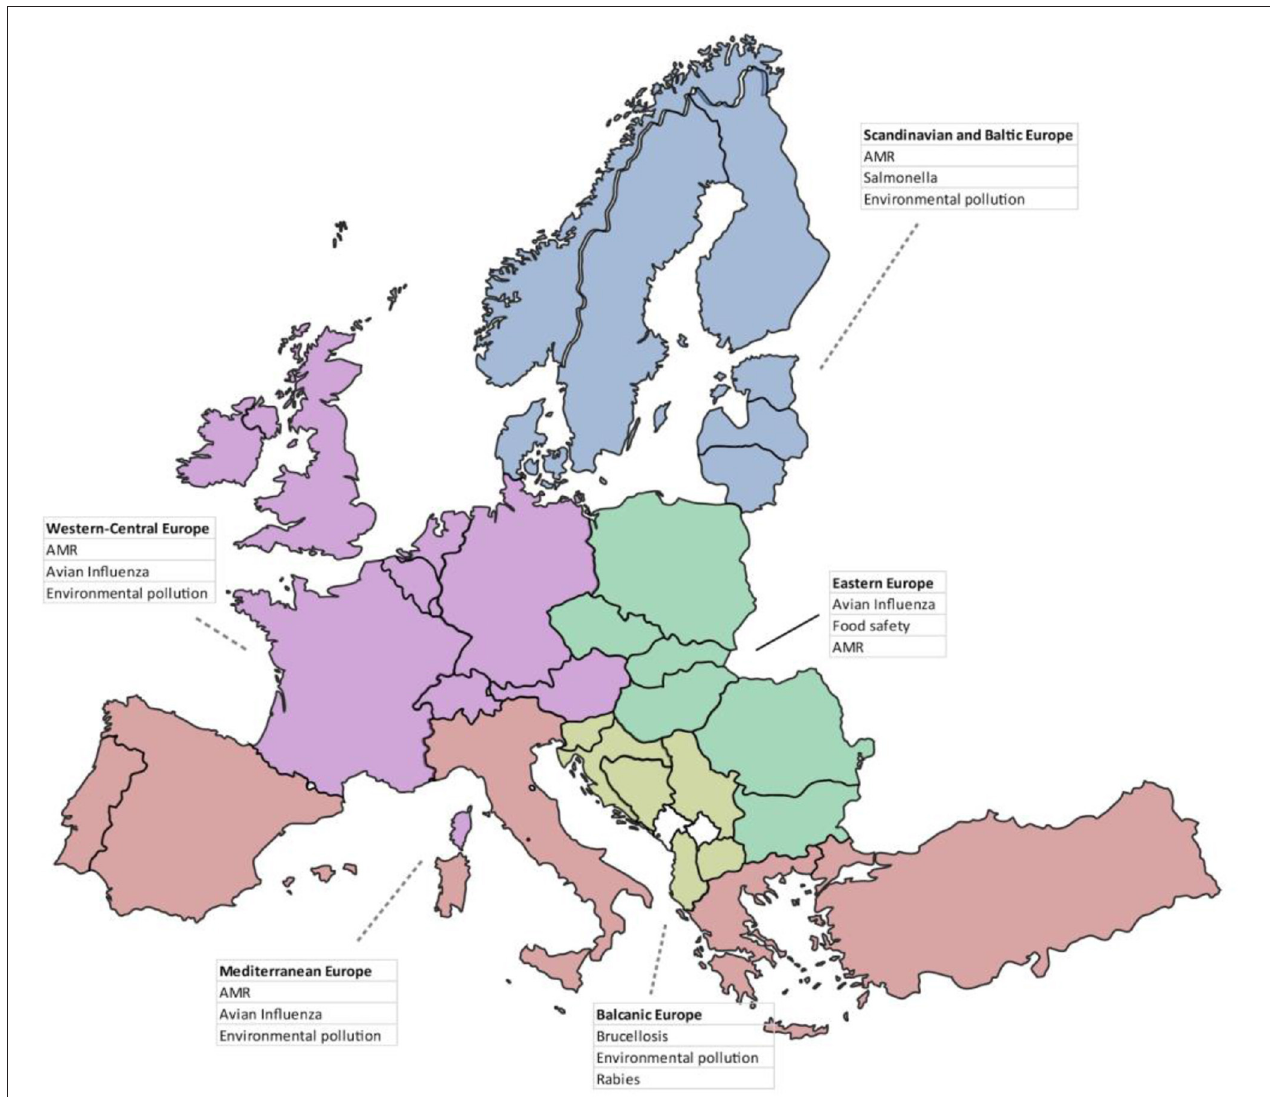
FIGURE 8 | Top three environmental, animal and human health issues over the past 5 years cited by respondents, divided by geographical